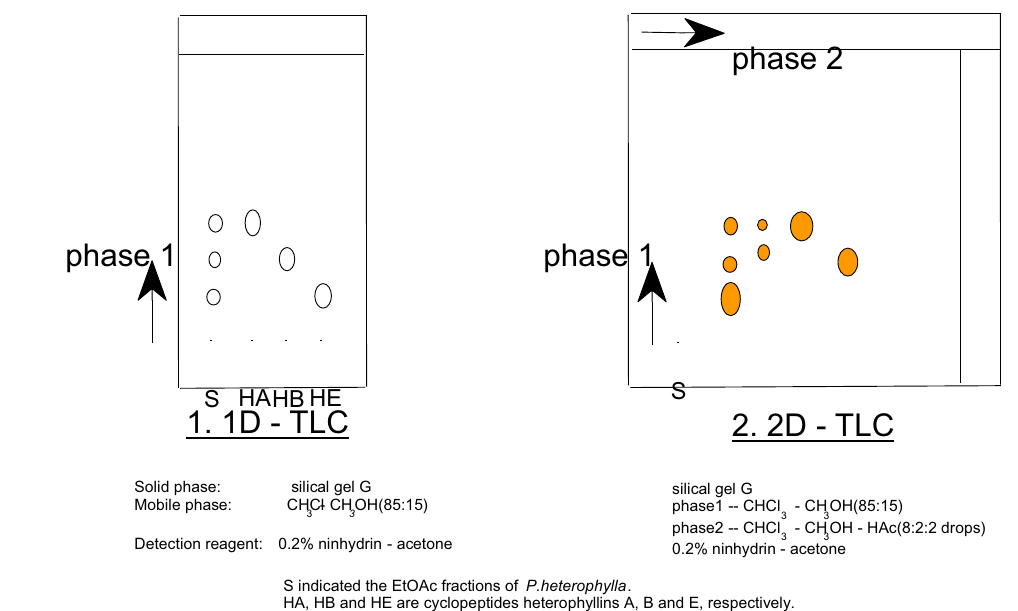
Fig. 8 Application of a new TLC method for detection of cyclopeptides in plants Fig. 9 Cyclization of heterophyllin B by cyclase from P.